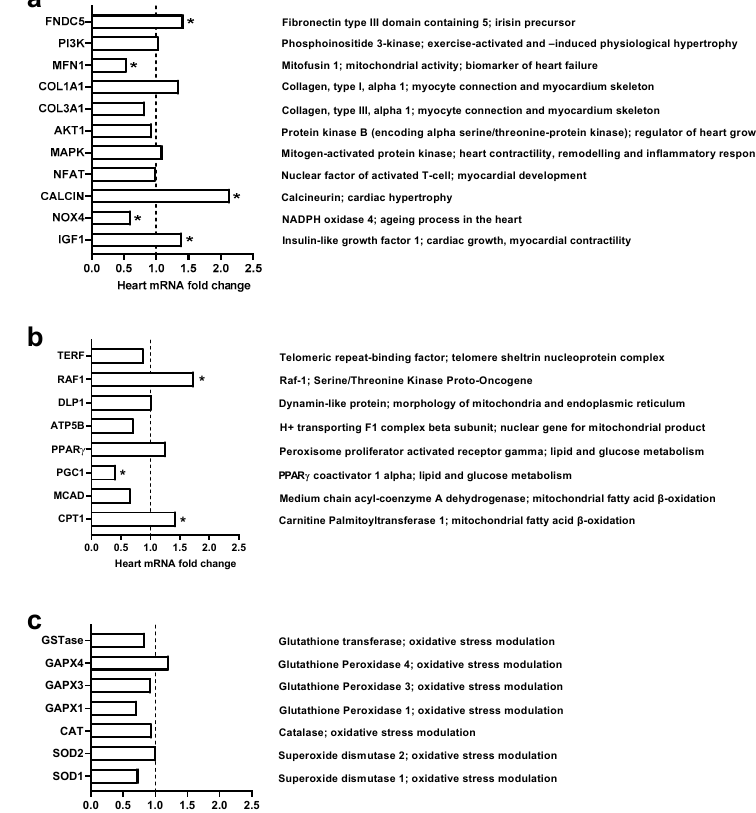
Figure 4. Effect of chronic administration of exogenous irisin (5 µ g /kg/day) for 42 days on heart mRNA levels ( n = 5). ( a ): Genes encoding for myocyte homeostasis and activity; ( b ): genes encoding for metabolism and mitochondrial activity; ( c ): genes encoding against oxidative stress. * p < 0.05 in comparison to the control group.